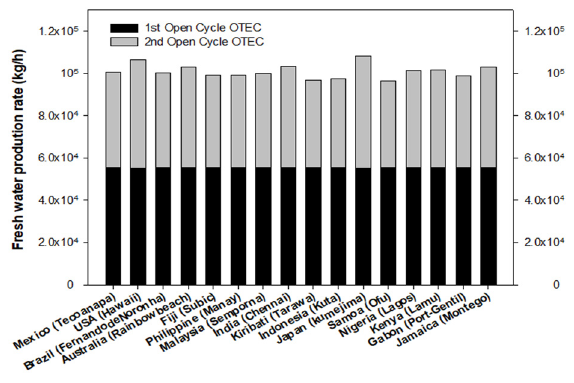
Figure 8. Freshwater production rate for OC-OTEC in application areas.